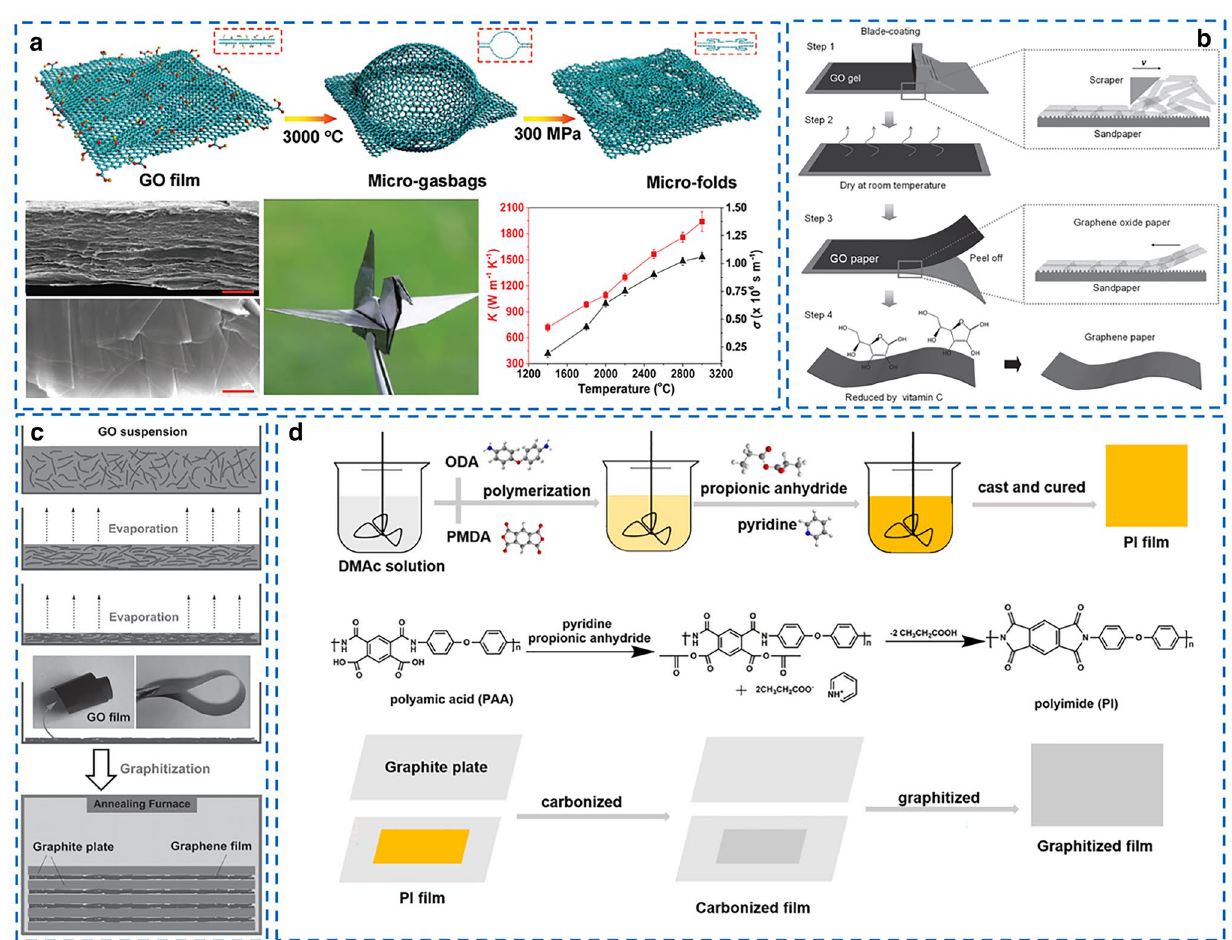
Fig. 7 Fabrication of thermally conductive all‑carbon films. a Preparation process of RGO film with micro‑folds via high‑temperature treatment and hot compression. Reproduced with permission from Ref. [14]. Copyright 2017, Wiley–VCH. b Preparation process of RGO film via blade coating and vitamin C reduction Reproduced with permission from Ref.[88]. Copyright 2017, Wiley–VCH. c Preparation process of RGO film by the evaporation of GO suspension and followed graphitization process. Reproduced with permission from Ref. [2] Copyright 2014, Wiley– VCH. d Preparation process of graphitized PI film by graphitization process of pure PI. Reproduced with permission from Ref. [102]. Copyright 2021,